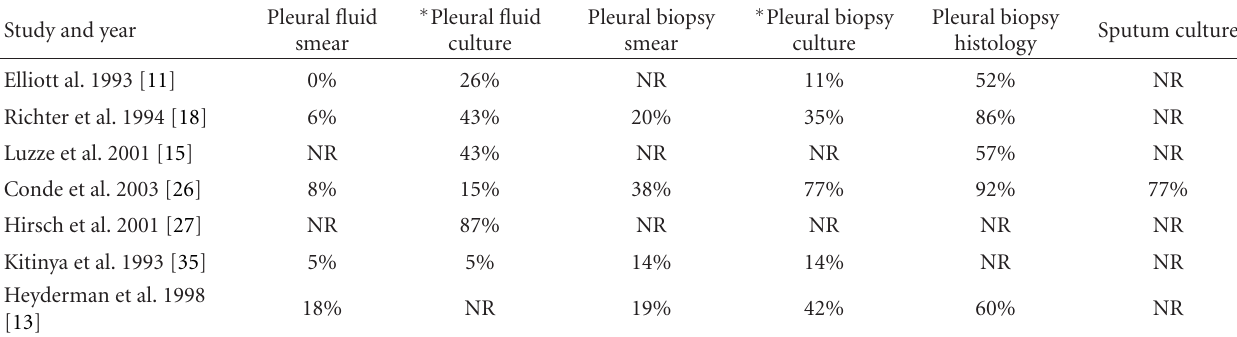
Table 3: Reported yields of di ff erent tests in HIV-infected patients with pleural